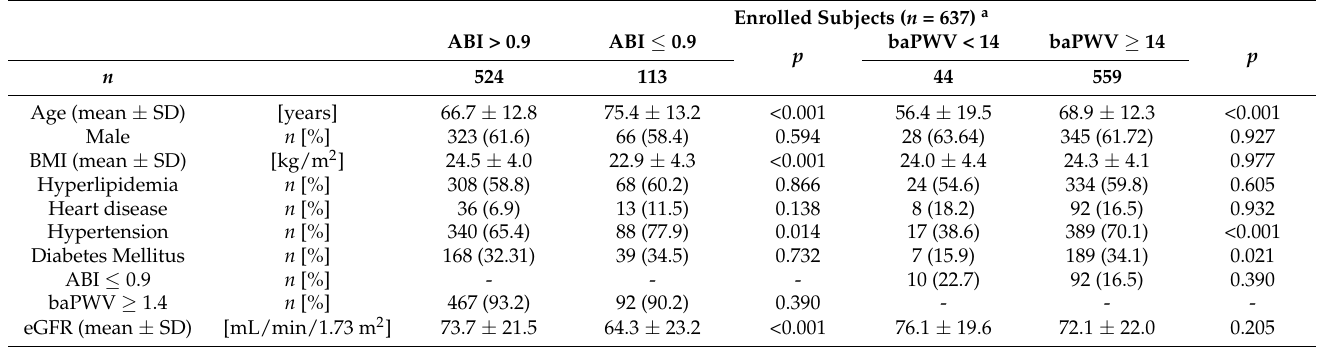
Table 1. Baseline characteristics and comorbidities of the enrolled subjects with acute ischemic stroke.